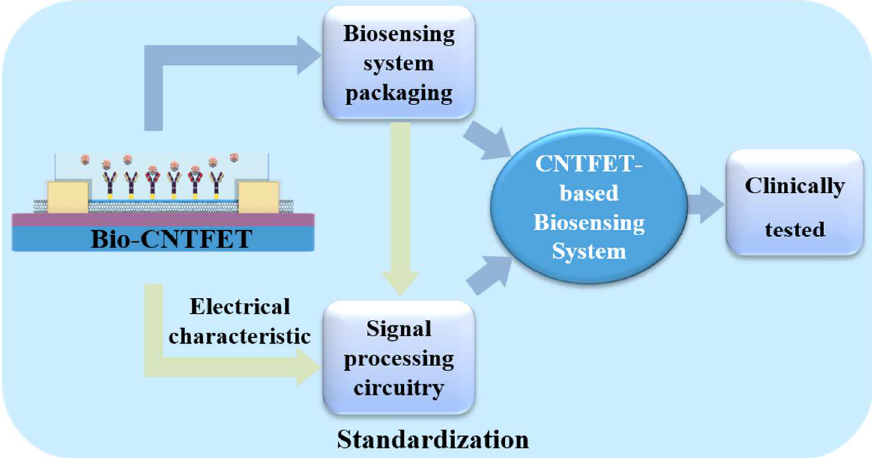
Figure 3. A necessary part of Bio–CNTFET commercialization process.